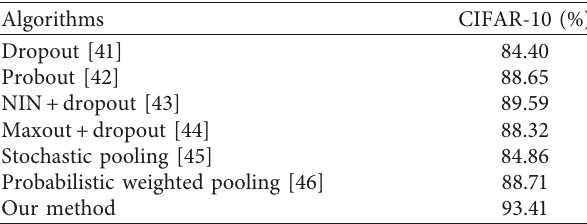
Table 2: Comparison with state-of-the-art algorithms on CIFAR-